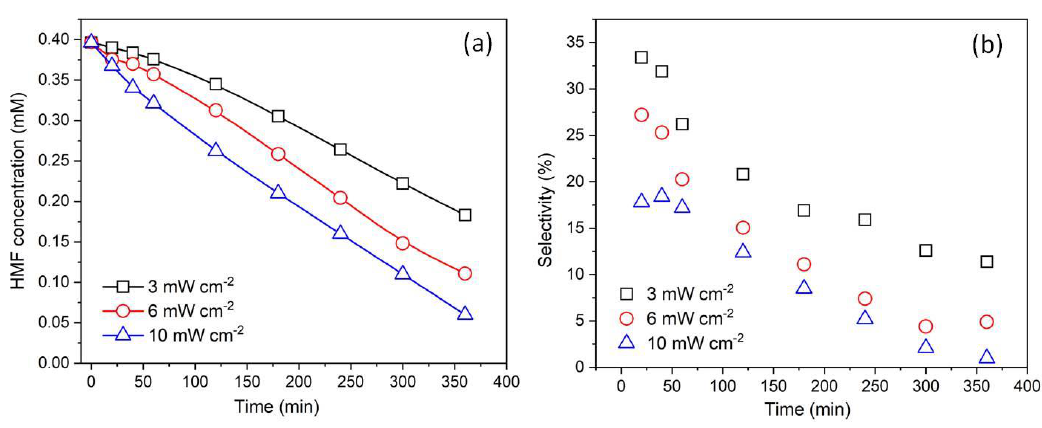
Figure 6. Experimental results on photocatalytic oxidation of HMF ( a ) and DFF selectivity ( b ) depending on irradiation intensity in the presence of electrochemically synthesized TiO 2 and methanol. Experimental conditions: catalyst dosage 1 g L −1 , HMF concentration 0.4 mM, methanol concentration 50 mM, O 2 flow 3 mL min −1 .